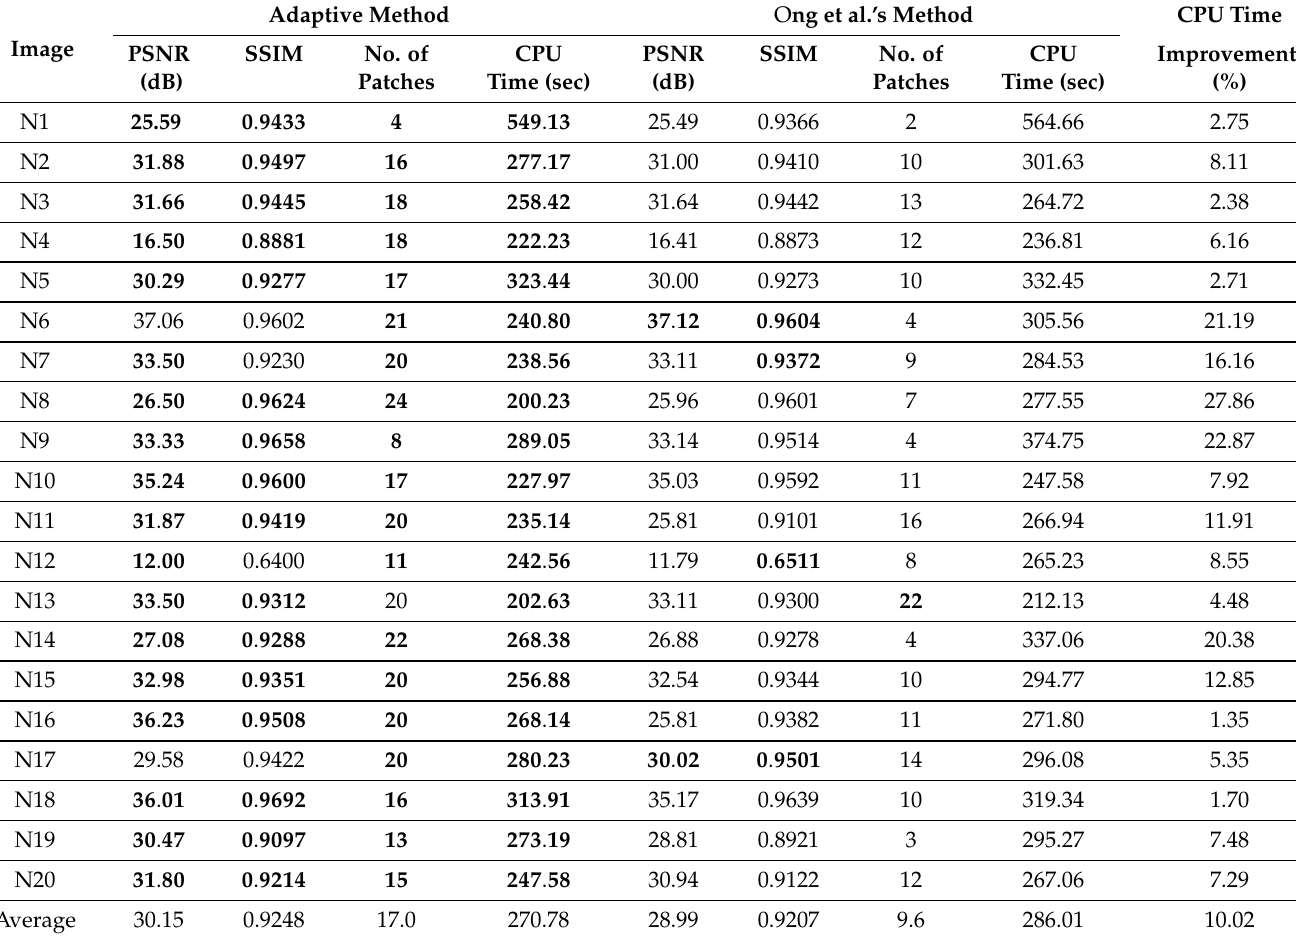
Table 1. Performance comparison between the proposed adaptive coefficient recovery method and Ong et al.’s method [7].